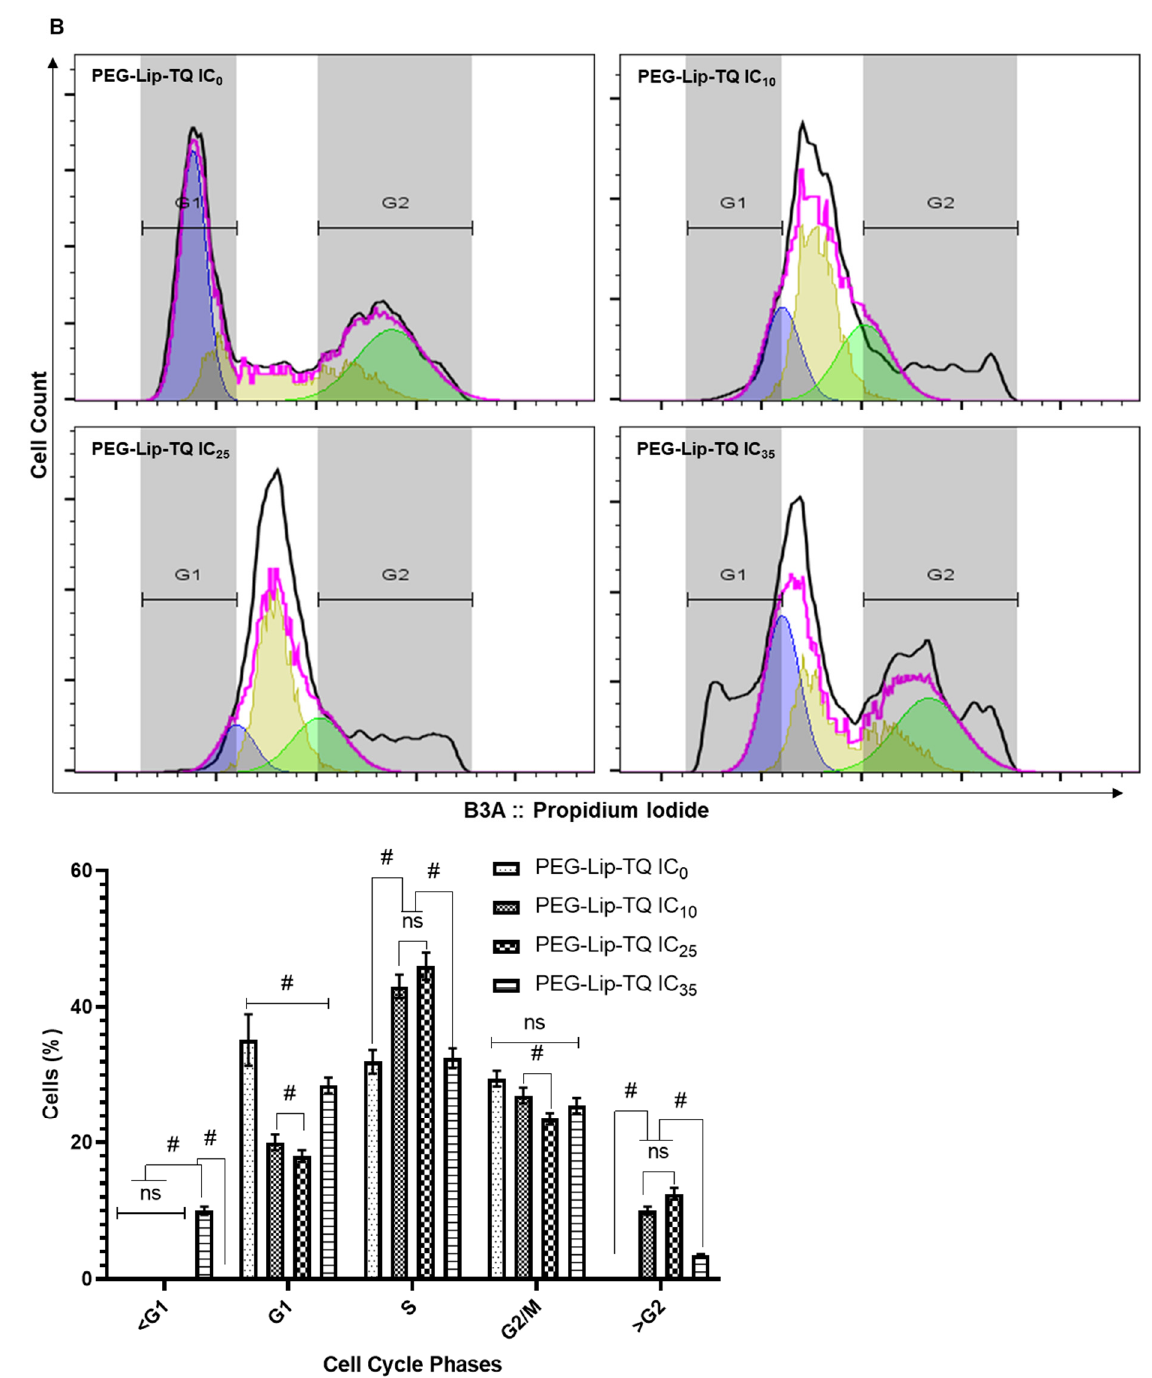
Figure 7. Effect of PEG-Lip-TQ cell cycle distribution by flow cytometry in lung cancer cells. ( A ) A549 cells, ( B ) H460 cells. The doses of PEG-Lip-TQ were selected as IC 10 and IC 25 and IC 35 as in the materials and methods. The values are expressed as mean ± SE of three independent experiments. NS No Significance within the groups, # Significant difference between the treated